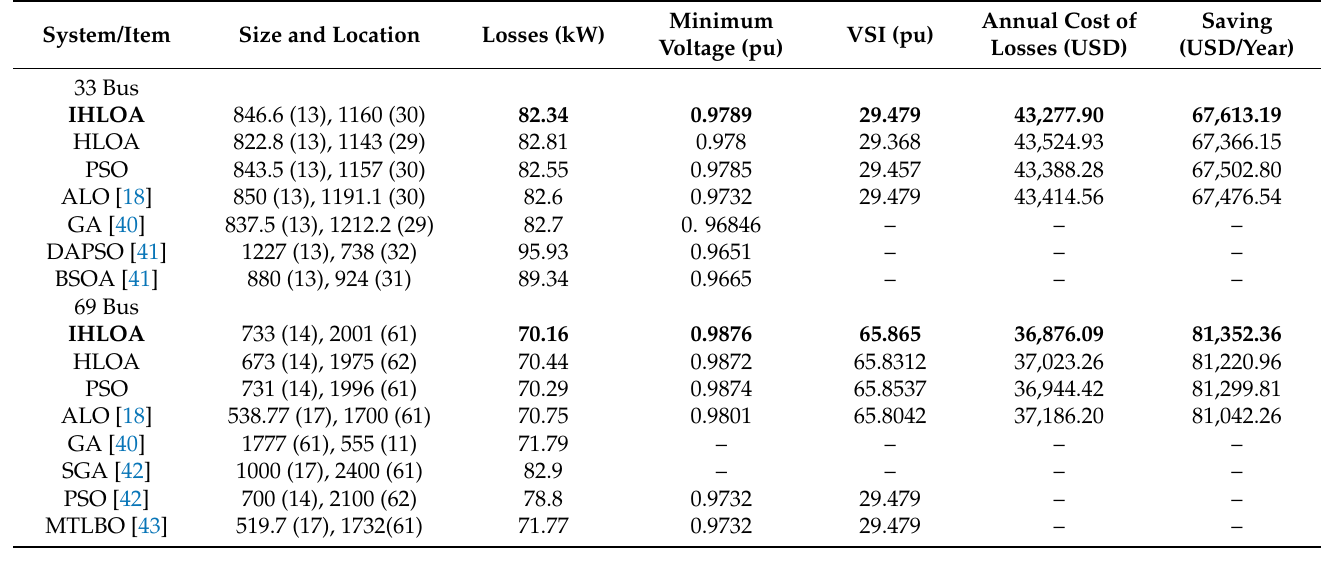
Table 3. Comparison of the results of sitting and sizing of two PV in deterministic condition.